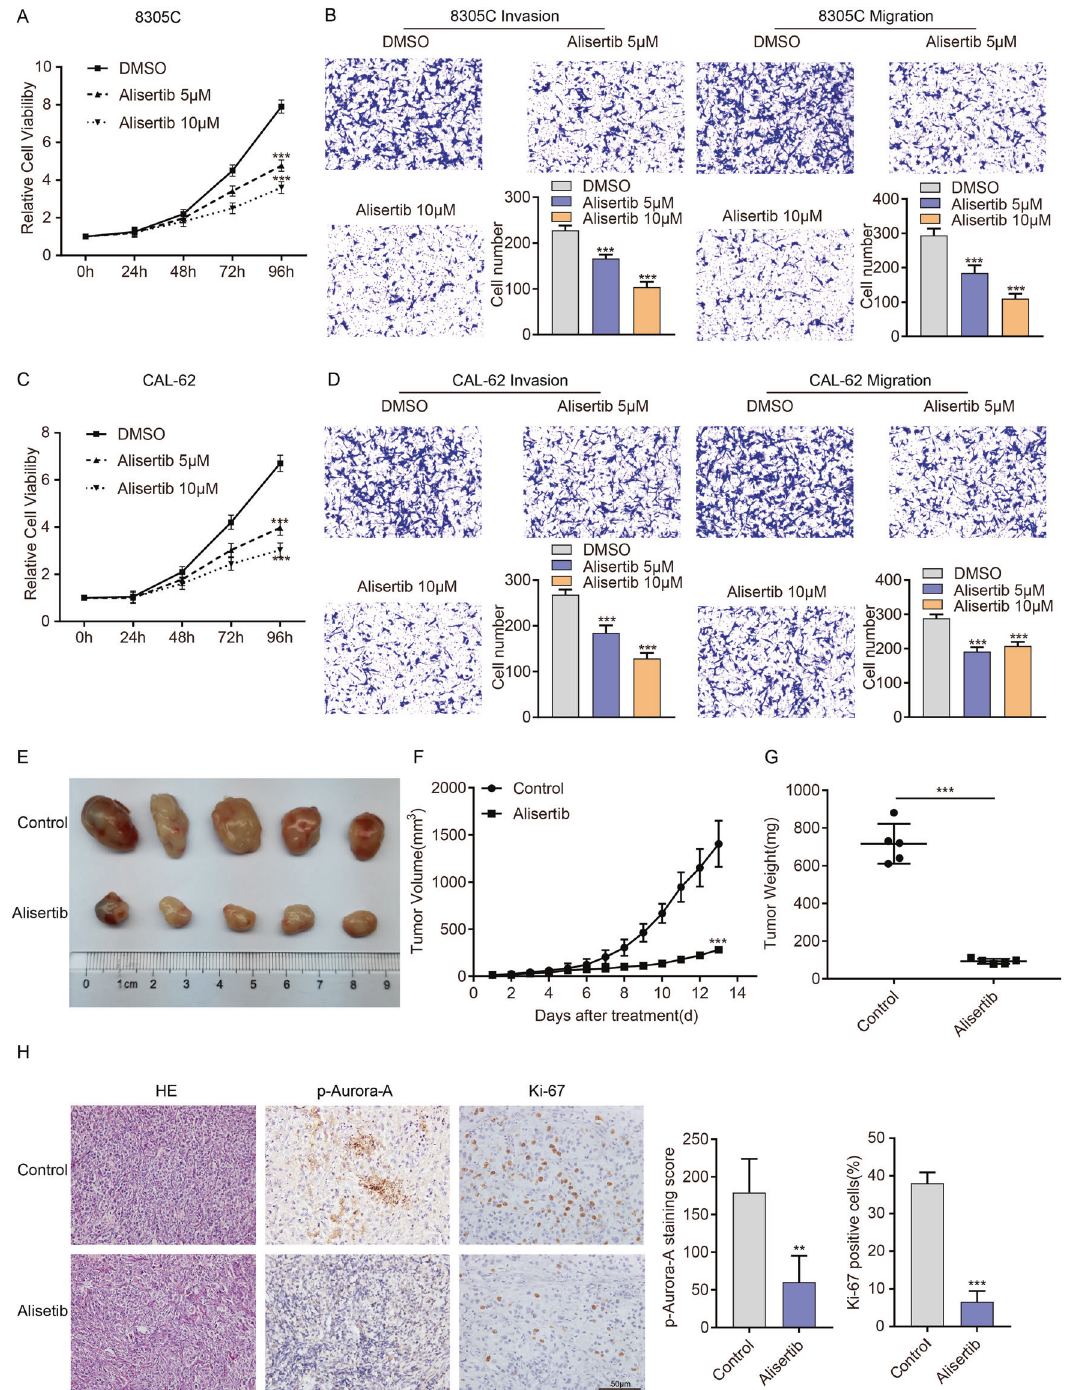
Fig. 1 Alisertib inhibits the proliferation, migration, and invasion of ATC cells in vitro and vivo. A , C CCK-8 assays showed that Alisertib (5 μ mol and 10 μ mol) treatment signi fi cantly suppressed cell proliferation in 8305 C ( A ) and CAL-62 ( C ) cells in a dose-dependent pattern. B , D After treatment with the indicated concentration of Alisertib for 2 days, the migration/invasion assay was performed in 8305 C ( B ) and CAL-62 ( D ) cells. Representative images are shown. The above data are presented as the mean ± SD of three independent experiments. E Five representative tumors from NSG mice injected with CAL-62 are shown, n = 5 mice per group. The subcutaneous xenografts were dissected and are shown on day 13. F , G Tumor volumes were measured with growth curves ( F ) and tumor weights ( G ) in the control group (DMSO) and Alisertib group (30 mg/kg). H Representative IHC images and p-Aurora-A and Ki-67 staining in xenograft tumor specimens of control and Alisertib groups are shown. p-Aurora-A and Ki-67 expression were signi fi cantly decreased after treatment with Alisertib. Scale bars, 50 μ m. The data are presented as the mean ± SD. All * P < 0.05, ** P < 0.01, *** P < 0.001, compared with the control